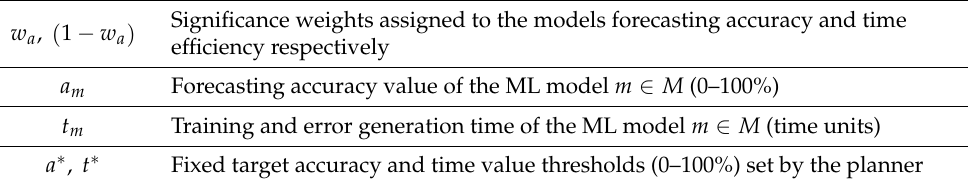
Table 2. Nomenclature of the deviation function parameters. Significance weights assigned to the models forecasting accuracy and w a , ( 1 − w a )